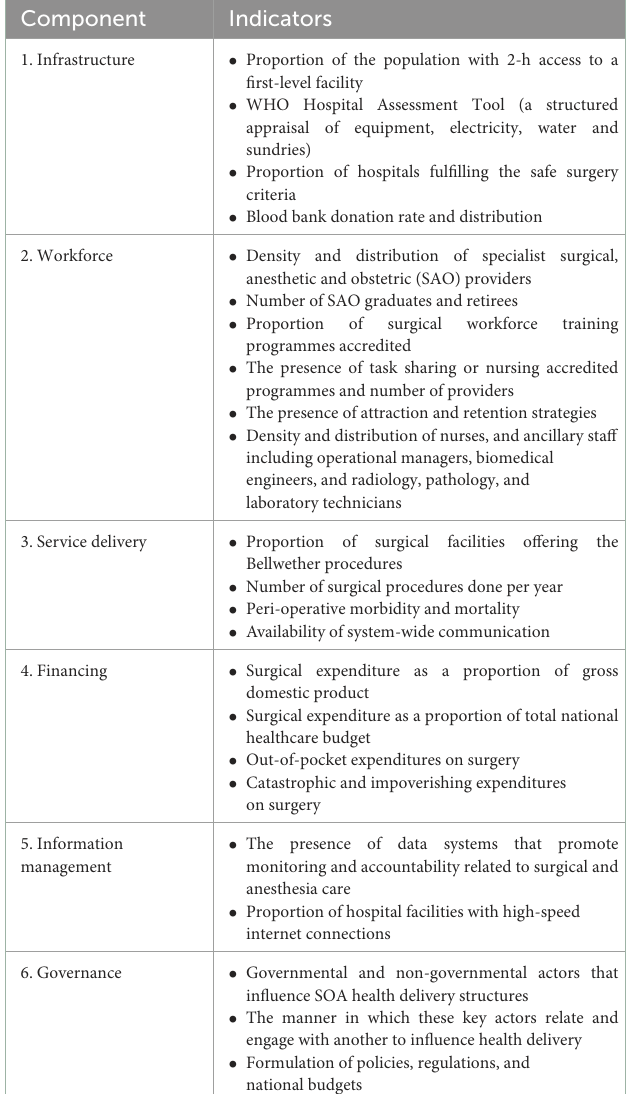
TABLE 1 The 6-component framework for surgical systems planning